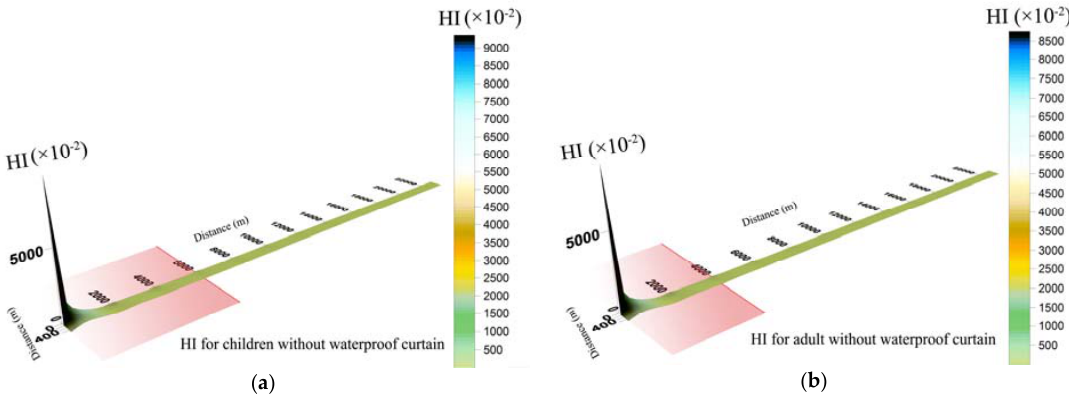
Figure 5. Spatial distribution of hazard index (HI) for children ( a ) and adults ( b ) during groundwater leakage without a waterproof curtain *. * The red region represents that the risk is unacceptable in longitudinal direction, but does not take the transverse range into consideration.